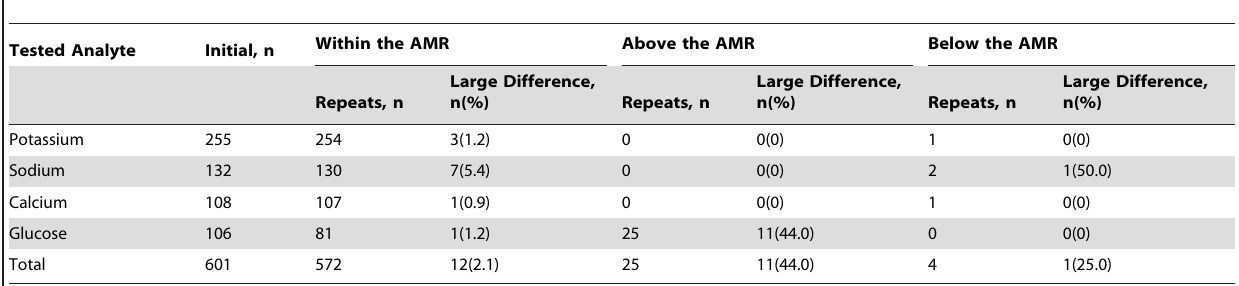
Table 2. Numbers and Rates of Repeat Tests Showing Large Difference*.